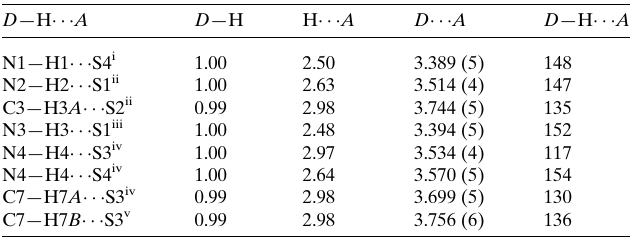
Table 2 Hydrogen-bond geometry (A˚ , (cid:5) ).